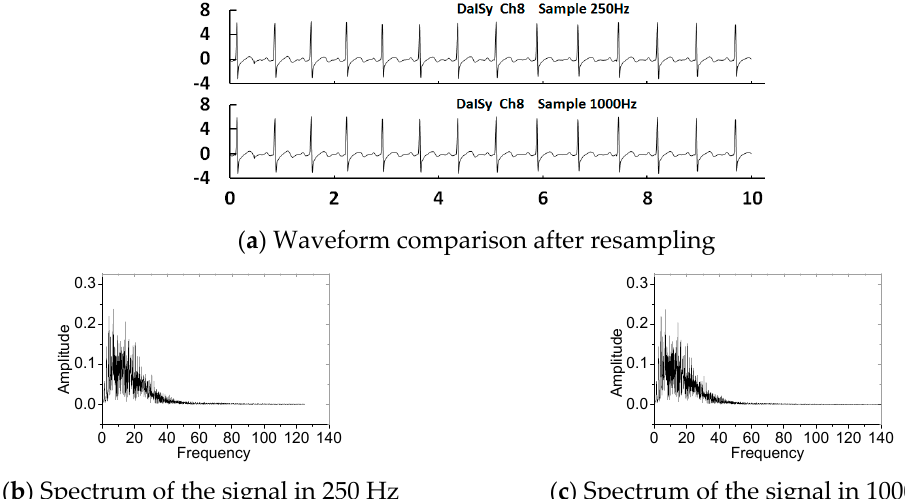
Figure 4. Direct scalp FECGs after filtering and eliminating baseline wandering in ADFECGDB.